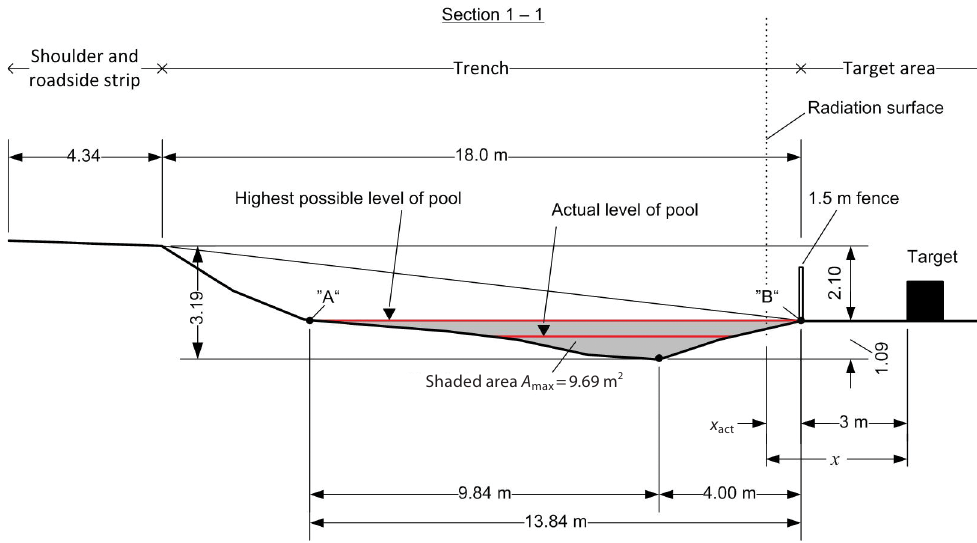
Figure 9. Cross-sectional dimensions of the trench at the assumed location of spill (see Section 1–1 in Figure 7)